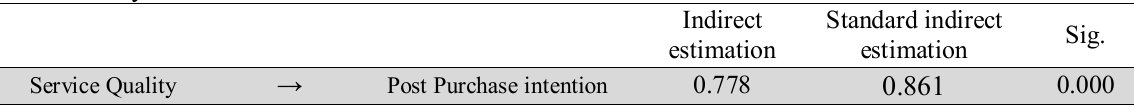
The summary of indirect